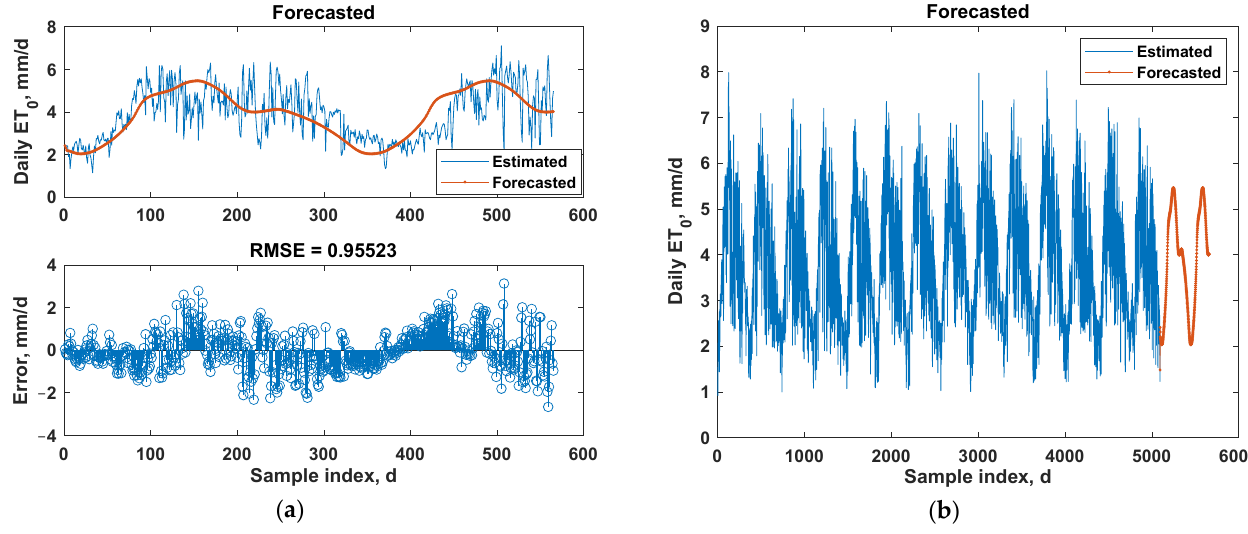
Figure 4. SSR-LSTM performance: ( a ) estimated (FAO-56 PM-computed) and SSR-LSTM-forecasted ET 0 values for the test dataset; ( b ) future projections beyond the observed ET 0 values.